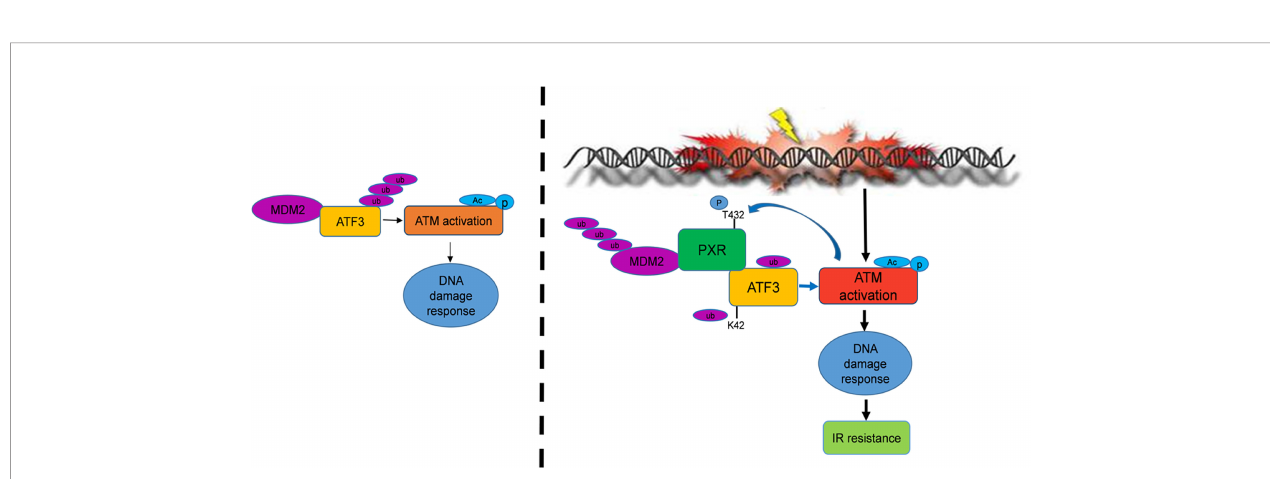
FIGURE 7 | PXR confers to IR resistance by promoting ATF3 stabilization. PXR stabilization of ATF3 protein contains two mechanisms: (1) PXR disrupts ATF3- MDM2 interaction, thus counteracts MDM2-mediated ubiquitination of ATF3. (2) PXR negatively regulates the expression of MDM2 and enhances its auto- ubiquitination and further reduces its half-life. PXR-ATF3 interaction is required for PXR-mediated stabilization of ATF3 as K42R of ATF3 lost binding with PXR and further abrogated PXR-mediated reduction of ATF3 ubiquitination. Furthermore, PXR-ATF3 interaction is also required for ATF3-mediated ATM activation as T432A mutant of PXR lost binding with ATF3, thus compromised ATF3-mediated ATM activation. Taken together, PXR promotes ATM activation and confers liver and colon cancer cell resistance to IR-induced DNA